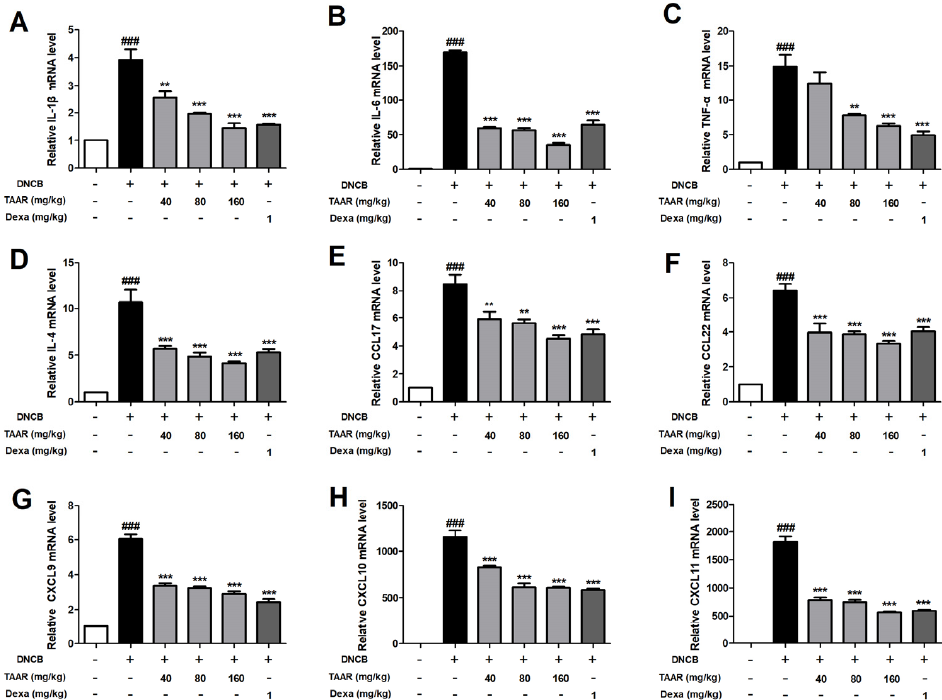
Figure 8. Effects of TAAR extract on the mRNA levels of DNCB-induced pro-inflammatory cytokines and chemokines in the dorsal skin tissue of DNCB-induced mice. mRNA expression of ( A – D ) cytokines IL-1 β , IL-6, TNF- α , and IL-5 and ( E – I ) chemokines CCL17, CCL22, CXCL8, CXCL10, CXCL11. All values are presented as the mean ± SEM of three experiments. Data were analyzed by Tukey’s post hoc test. ### p < 0.001 vs. normal control group; * p < 0.05, ** p < 0.01, and *** p < 0.001 vs. DNCB-treated only group.